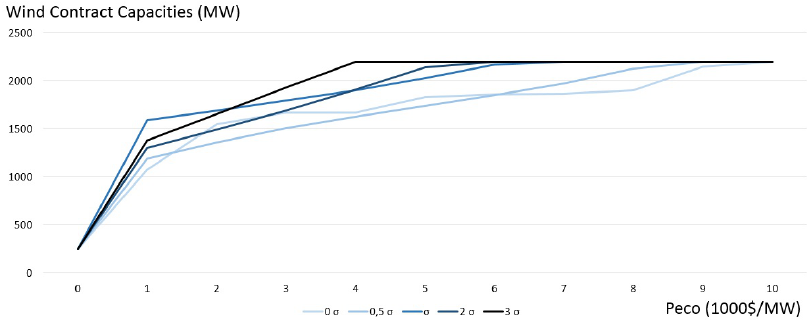
Figure 9. Variation of the optimal wind energy contract capacity with respect to P eco and σ (own results).